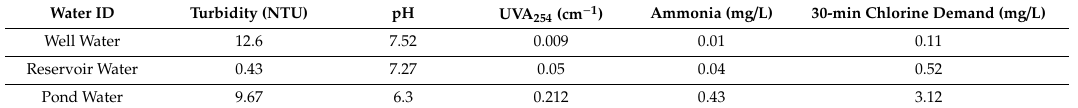
Table 4 below. These values were measured right before the water was dosed with chlorine. The three water samples were dosed with a pre-determined dose of 4 mg/L chlorine, and the chlorine decay curves were predicted using the developed methods and compared with the actual measurements. A comparison of the predicted chlorine decay curves and actual decay curve can be seen in Figure 8. Table 4. Water quality parameters of the three natural water sampled. Table 4. Water quality parameters of the three natural water sampled.